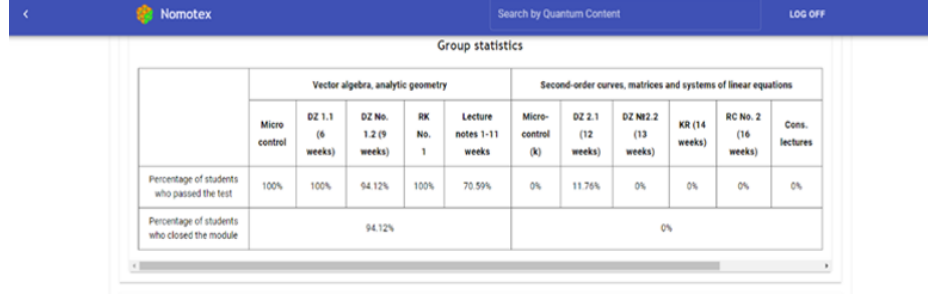
Fig. 7. Window of the subsystem «Performance Analysis» in the Nomotex